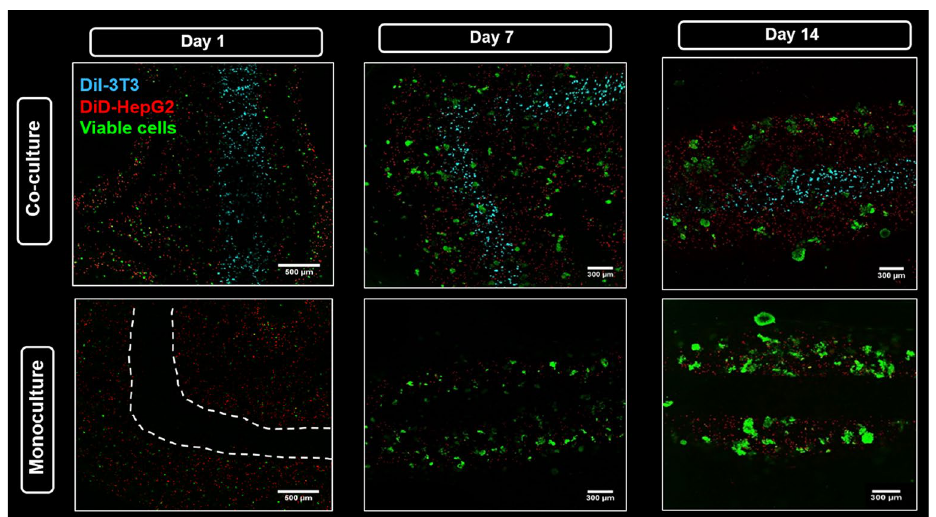
Figure 10. Viability and localization of HepG2 in co-culture with NIH 3T3 and in monoculture in core–shell strand scaffolds. Confocal images show DiD-labeled HepG2 (red) encapsulated in shell compartment consisting of algMC + Matrigel with either NIH 3T3 fibroblasts encapsulated in algMC core and labeled with DiI (cyan) (upper tile) or with a cell-free algMC core (lower tile). Viable cells were stained with Calcein-AM (green). Figure shows the progression of cell cluster formation of hepatocytes over the culture period. Scale bar (day 1) 500 µm; scale bar (days 7 and 14) 300 µm; white dashed line indicates here the core–shell